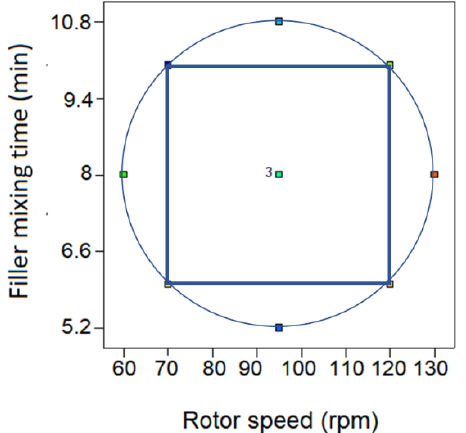
Figure 2 . Central Composite Circumscribed (CCC) design setup . Figure 2. Central Composite Circumscribed (CCC) design